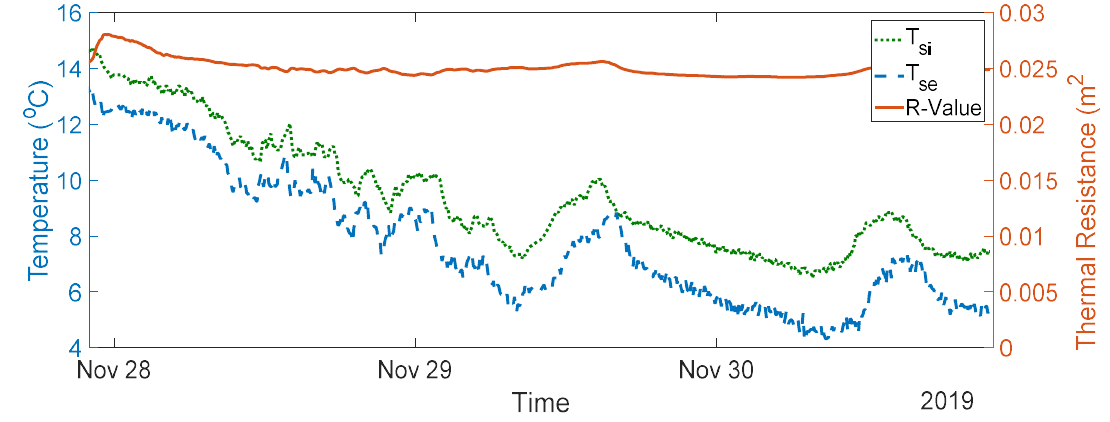
Figure 11. Thermal resistance measurement data from Day 1 to Day 3.